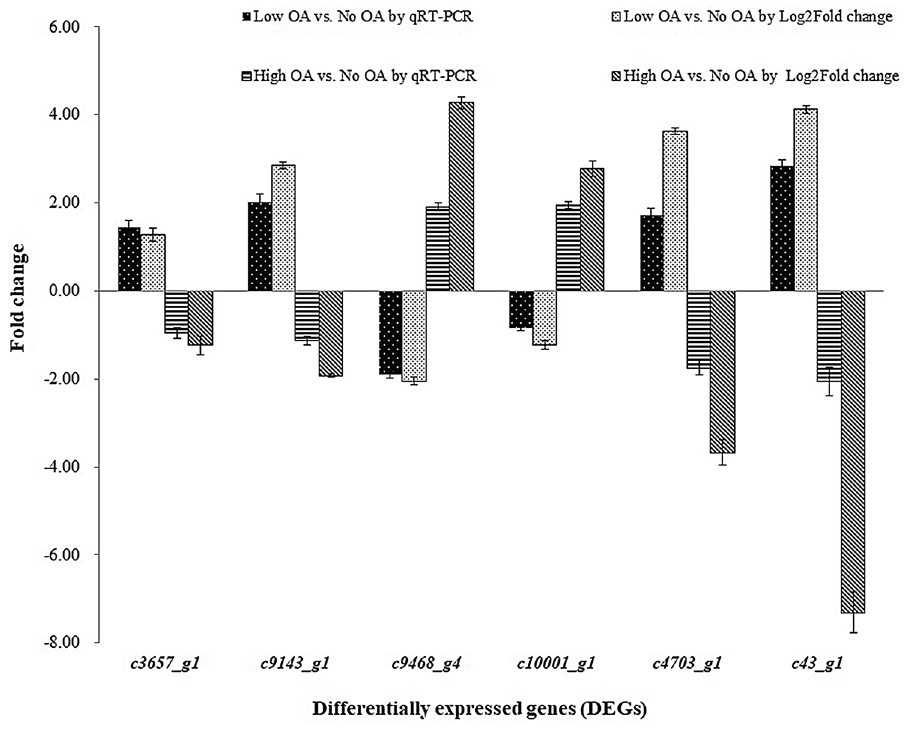
Figure 3. Validation of the DEGs using qRT-PCR. Fold changes of the expression of the selected DEGs including c3657_g1 , c9143_g1 , c9468_g4 , c10001_g1 , c4703_g1 and c43_g1 between Low OA or High OA and No OA by qRT-PCR and RNA-seq were represented.